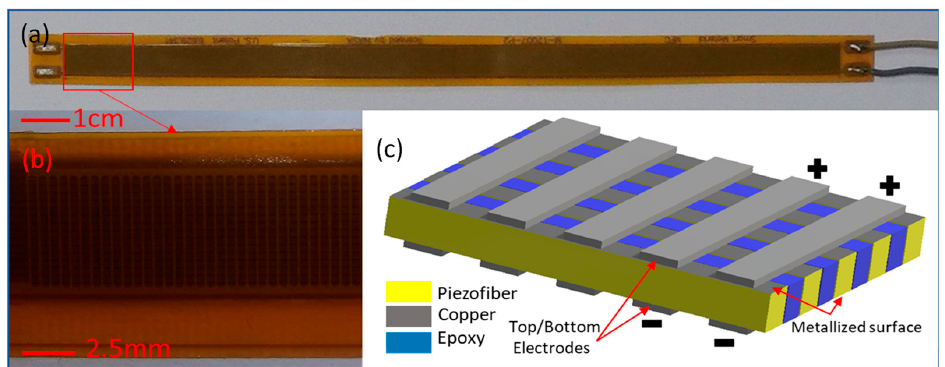
Figure 1. The proposed open-water wave energy converter (OWEC) with P2-type macro-fiber composites (MFCs), M17007-P2 model. ( a ) The P2-type MFC module using the d 31 piezo index. ( b ) A magnified image of the MFC. The top electrode and the fibers can be seen clearly. ( c ) Schematic details of MFC: the bottom–top electrodes, together with top/bottom surface metallization of the piezo-fibers, form the internal connections of the MFC. The bottom–top electrodes’ configuration helps P2-type MFCs to collect more charge in comparison with P1-type MFCs, which have interdigitated